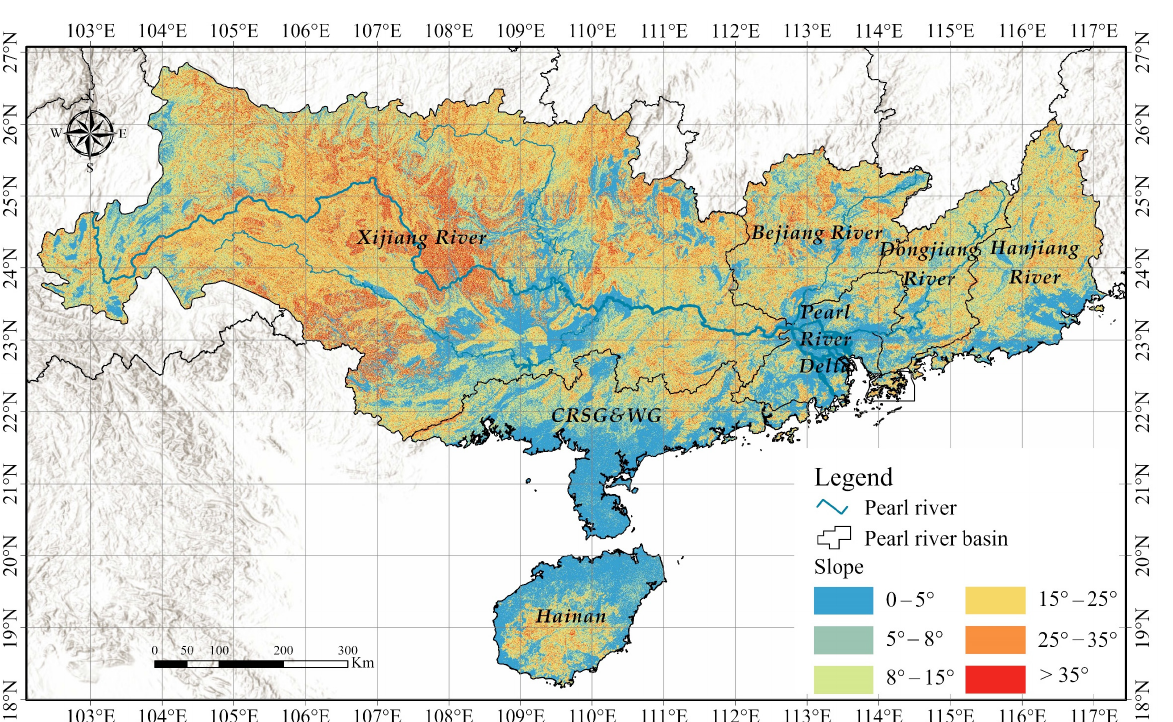
Table 1. Data sources and descriptions.